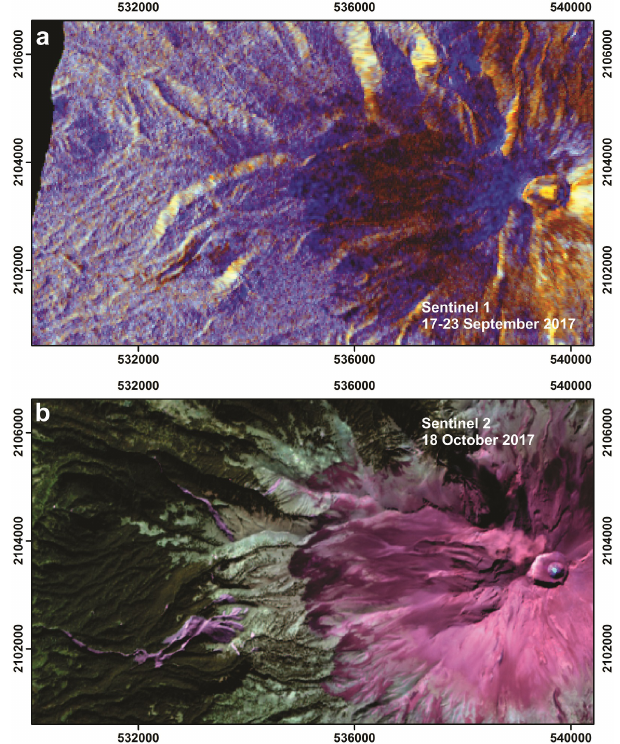
Figure 9. (a) RGB (R, post-earthquake; G, pre-earthquake; B, ratio between post- and pre-event) representation of the 17 and 23 September Sentinel-1 (© Copernicus data) change in amplitude analysis. (b) RGB composition of post-event Sentinel-2 image (© Copernicus data). Coordinate system WGS84 UTM Zone